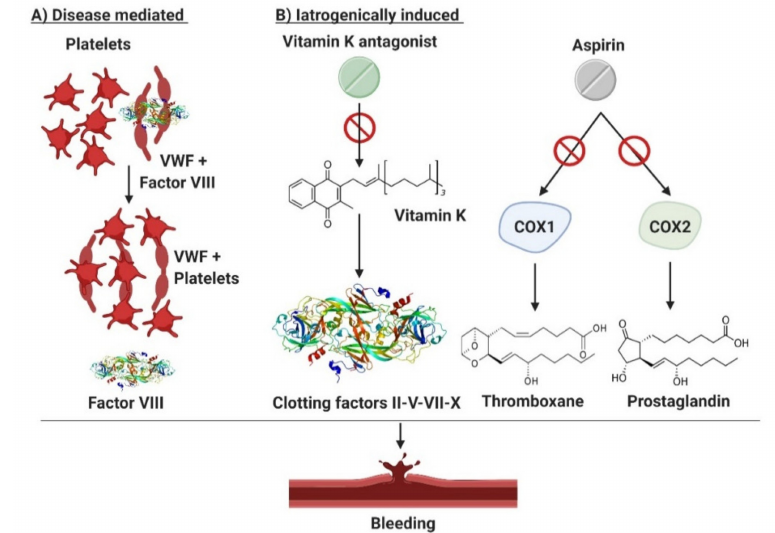
Figure 1. Bleeding mechanisms in patients with essential thrombocythemia. Patients with ET are prone to bleeding from AVWS or due to the use of antiplatelet / anticoagulant drugs. ( A ) illustrates the disease mediated mechanism in setting of excessive thrombocytosis which may cause AVWS due to in vivo absorption of VWF multimers. ( B ) describes iatrogenically induced bleeding risk in ET. Aspirin suppresses the production of thromboxane and prostaglandins by inactivating cyclooxygenase enzymes 1 and 2 (COX1 / 2) and thus impairing platelets aggregation. Vitamin K antagonist (used in selected patients with ET with active or prior thrombosis) have an intrinsic bleeding risk because of their narrow therapeutic window. Finally, excessive thrombocytosis may cause AVWS due to in vivo absorption of VWF multimers. COX1 / 2, cyclooxygenase enzymes type 1 and 2; VWF, von Willebrand